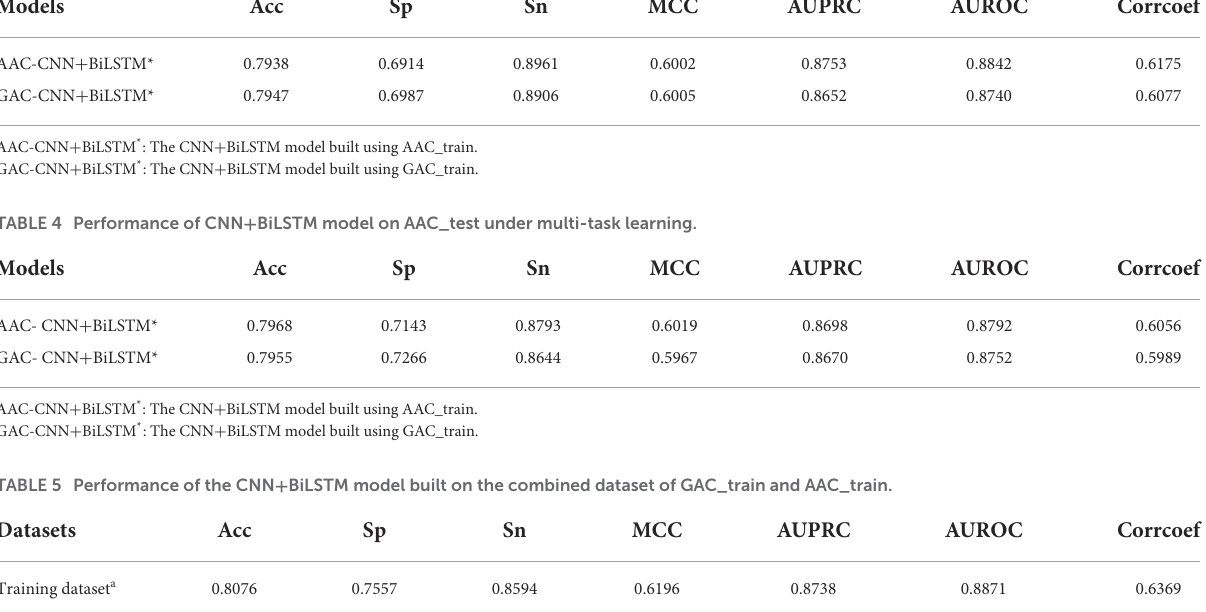
TABLE 3 Performance of CNN + BiLSTM model on GAC_test under multi-task learning. Models